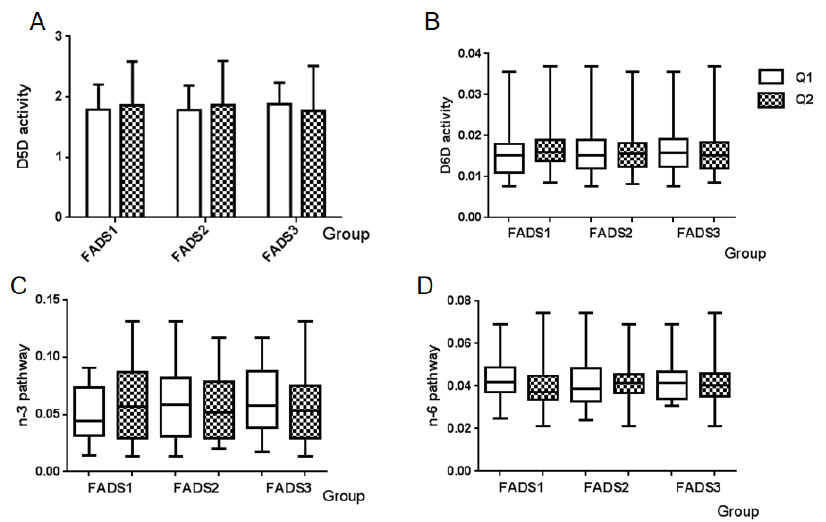
Figure 3. Distributions of enzyme activity and PUFA pathway activity among FADS gene expression groups. ( A ) D5D activity, ( B ) D6D activity, ( C ) n-3 PUFA pathway, and ( D ) n-6 PUFA pathway. Q1: Low mRNA expression group, Q2: High mRNA expression group.